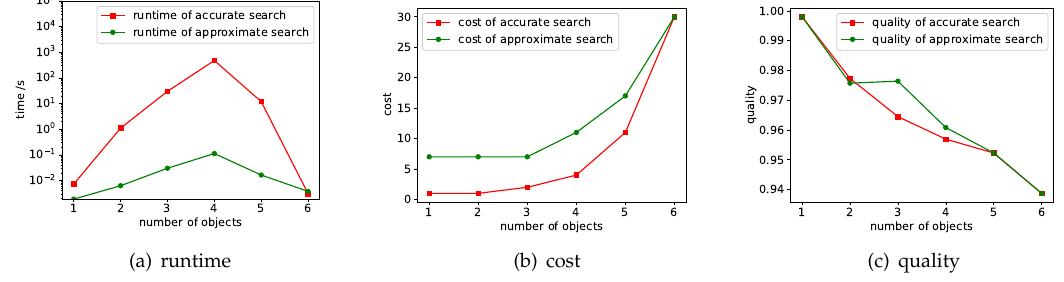
Figure 6. Experimental results when varying | O Q | .